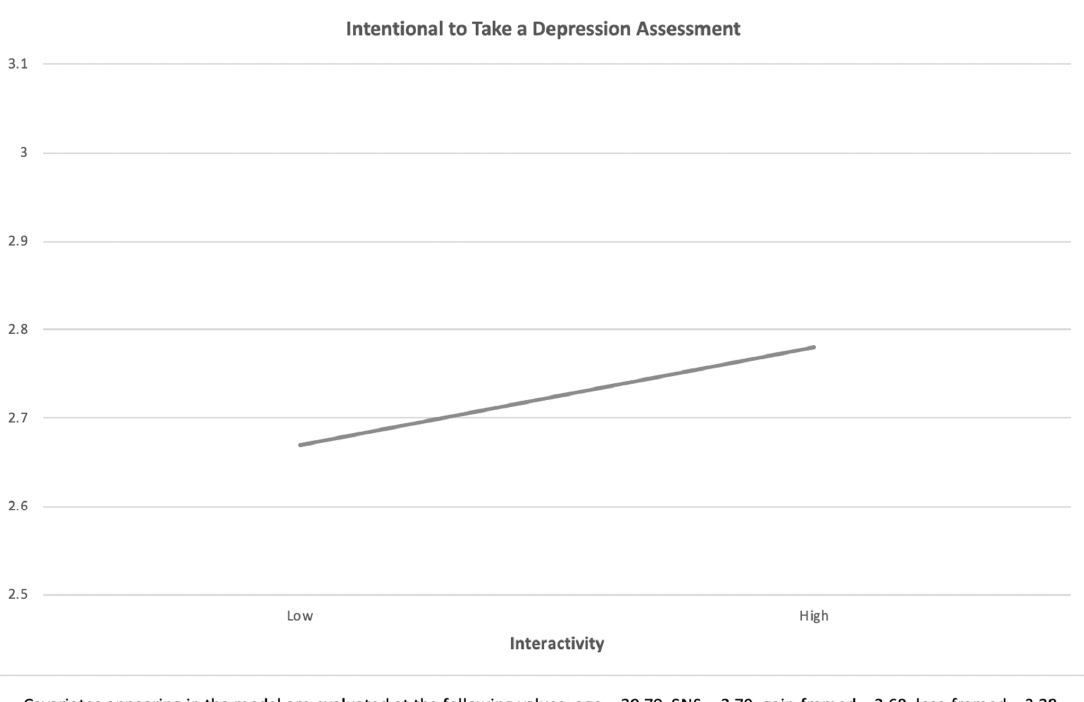
Figure 2. Main effect of interactivity on the intention to take a depression examination